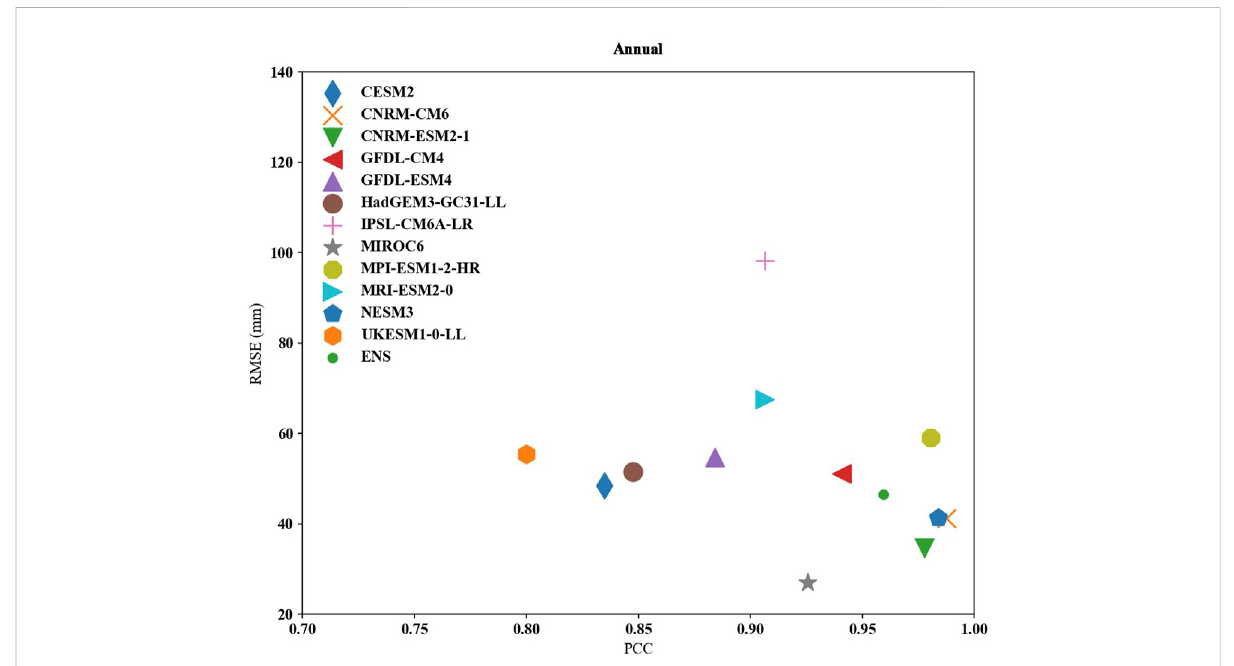
FIGURE 15 Performance of mean annual cycle PRE (mm) for CMIP6 models and their multimodal ensemble mean (ENS) on PRE climatology (1970-2014). The abscissa and ordinates are pattern correlation coef fi cient (PCC) and root mean square error (RMSE),